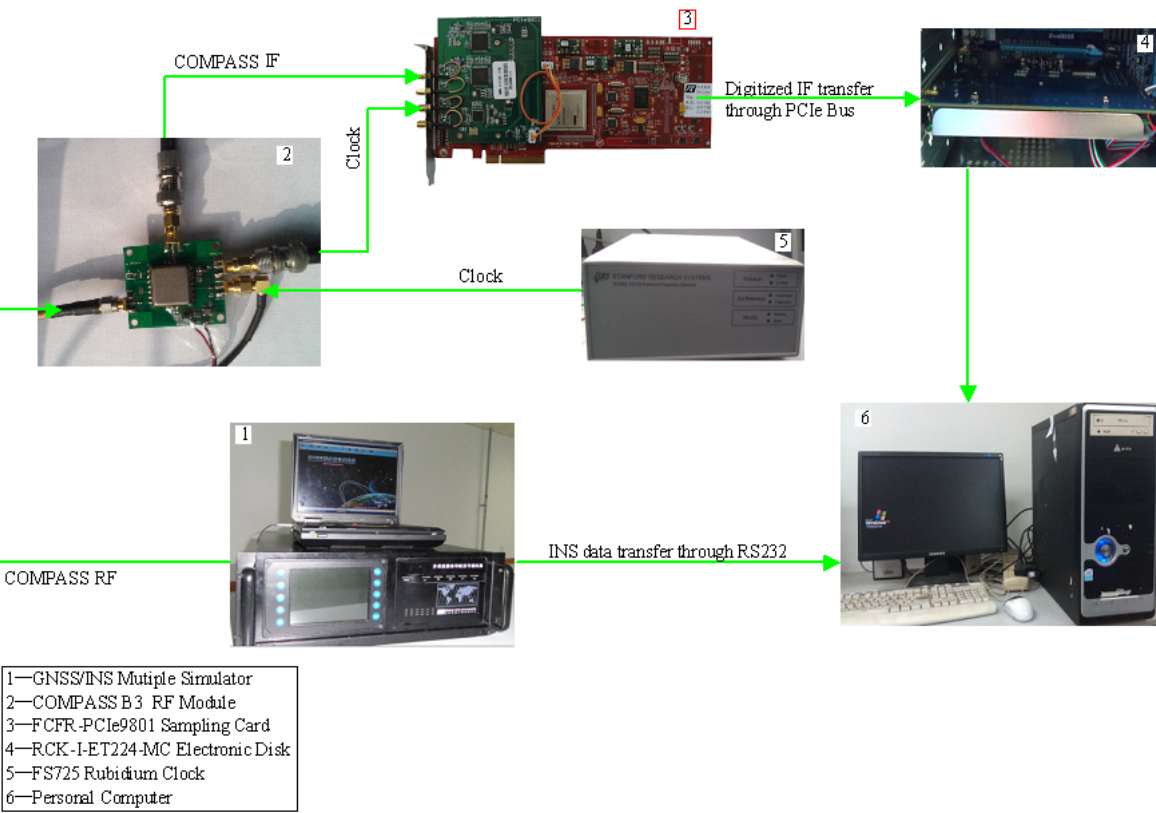
Figure 5. COMPASS IF data and INS data collection process with GNSS/INS hardware